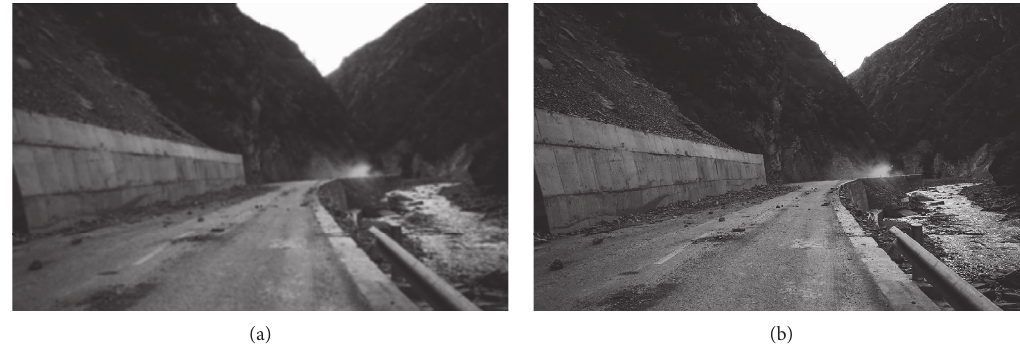
Figure 14: Comparison of the processing results of road images between the target detection algorithm and the semantic segmentation algorithm. (a) Analysis and processing of images by target detection algorithm; (b) analysis and processing of images by semantic seg- mentation algorithm.